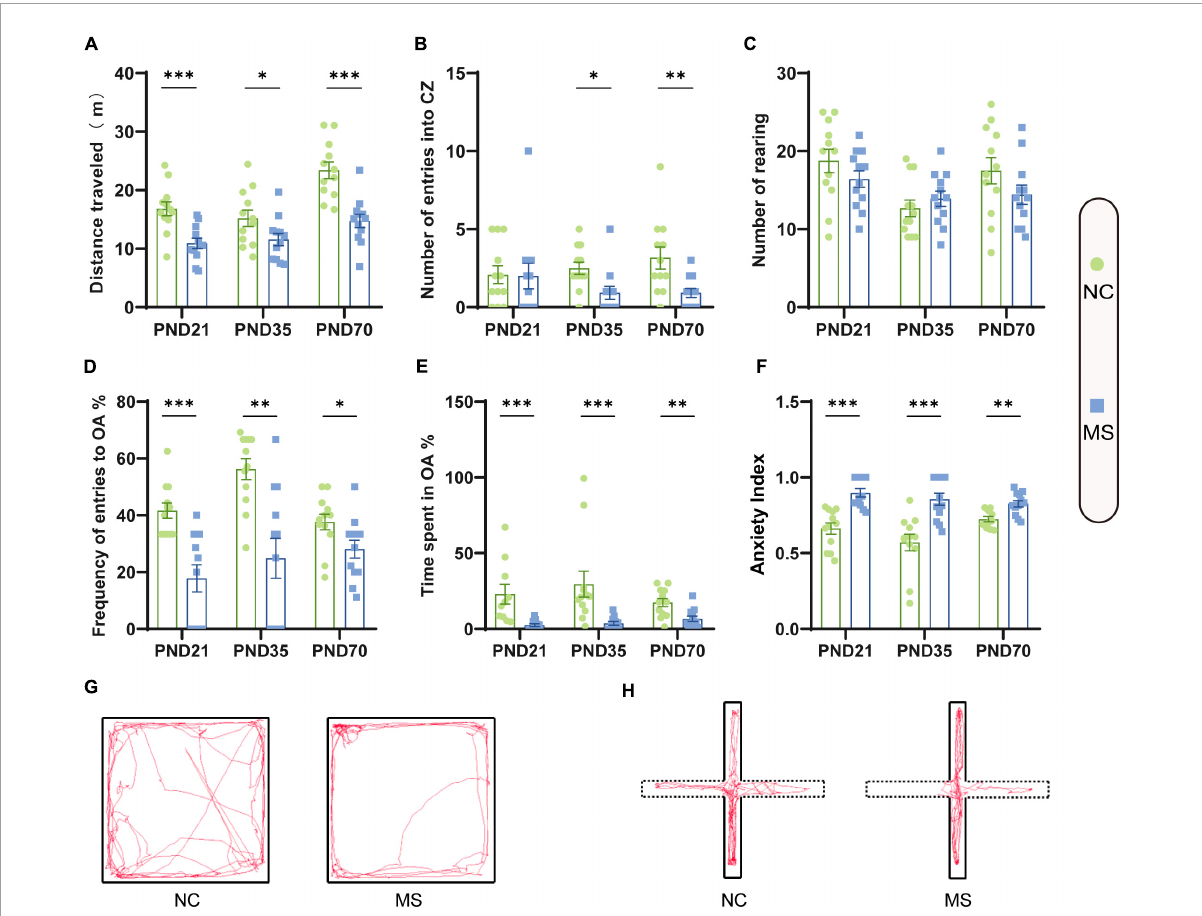
FIGURE3 Anxiety-like behaviors were increased in rats of MS groups. Before EMG recordings, all rats were subjected to the OFT test (A–C) and EPM test (D–F) to evaluate anxiety-like behaviors. (A) The distance traveled by MS rats in the open field was significantly less than that of NC rats. (B) On PND35 and PND70, MS rats showed less entries into the center zone (CZ). (C) There was no significant difference in the number of rearing in the three age periods. (D) MS rats on PND21, PND35, and PND70 showed a significantly lower probability of open arms (OA) entries than NC rats. (E) MS rats in three groups spent significantly less percentage of time in the OA than NC rats. (F) MS rats in three groups showed a significantly higher anxiety index than NC rats. The anxiety index integrated with the EPM behavioral measures was calculated as follows: anxiety index = 1 − [(time spent in OA/total time on the maze) + (number of entries to the OA/total exploration on the maze)/2]. On PND21: NC, n = 12; MS, n = 12. On PND35: NC, n = 12; MS, n = 12. On PND70: NC, n = 12; MS, n = 12. All data were given as mean ± SEM. ∗ P <